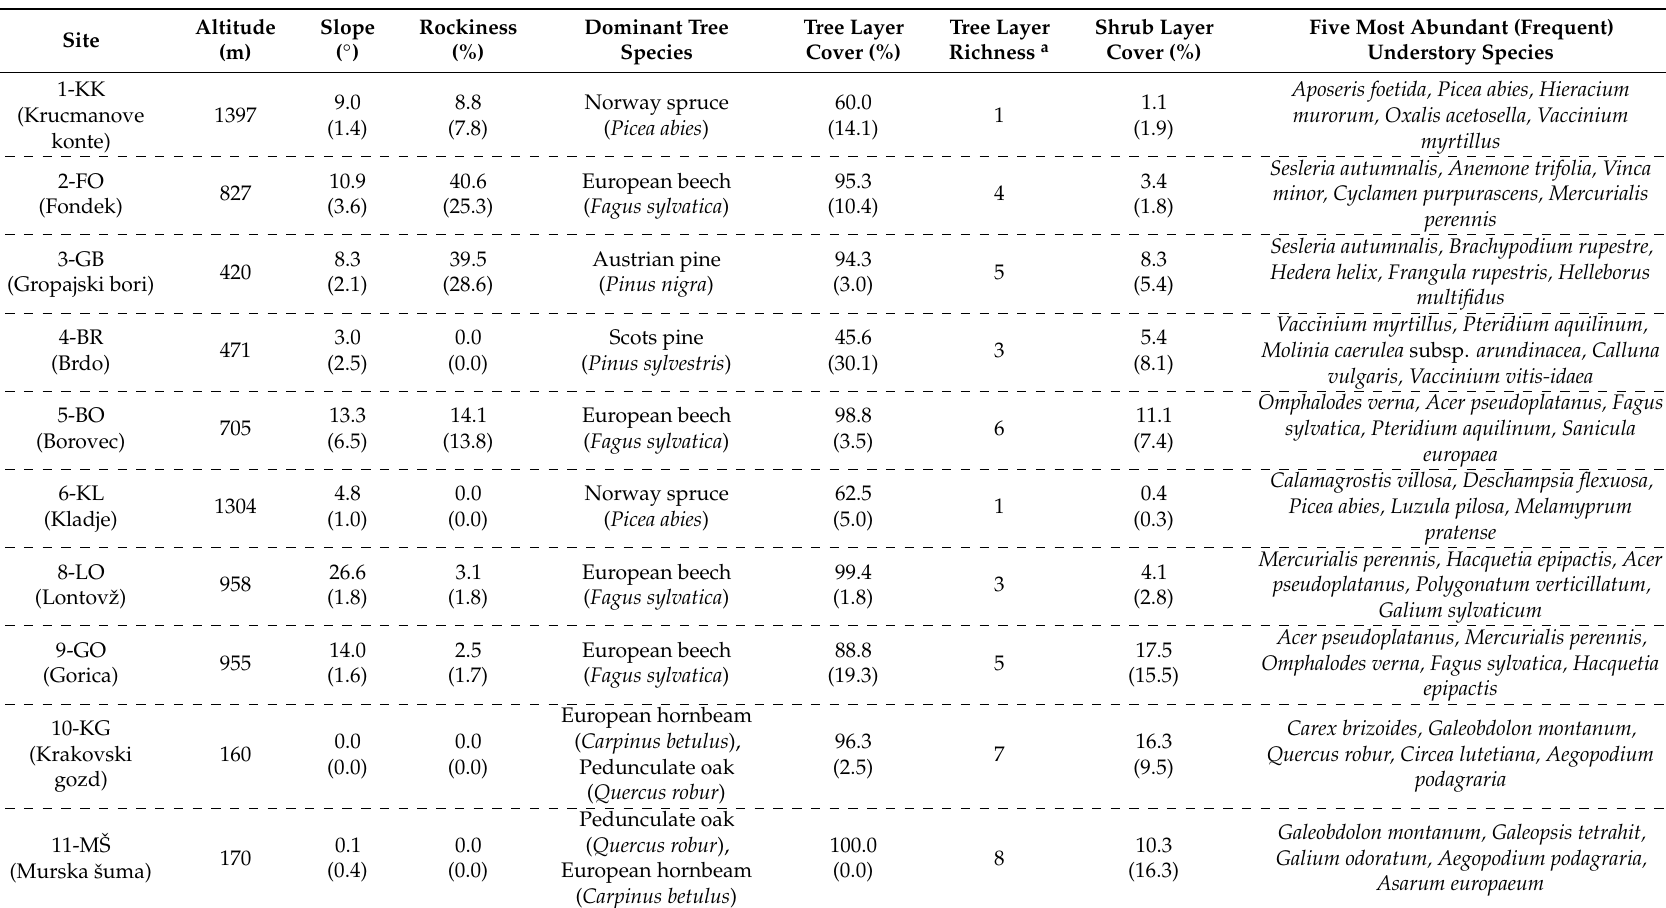
Table 1. Main environmental and vegetation characteristics of 10 study sites in Slovenia, based on data from large vegetation plots (10 × 10 m). Values are mean ±